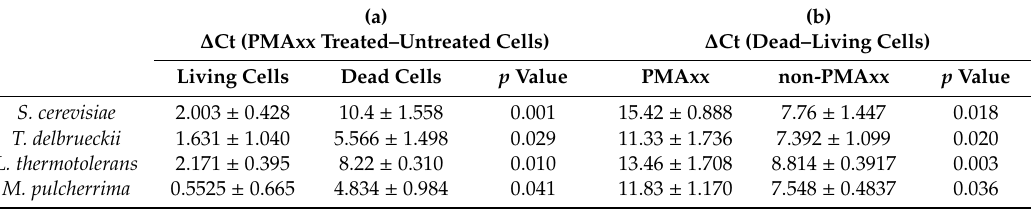
Figure 1. Schematic representation of the e ff ect of PMAxx treatment in living and dead cells. Red arrows represent the cycle threshold (Ct) reduction obtained by subtracting the mean Ct values of living cells from those of dead cells, (1) with or (2) without PMAxx treatment. Green arrows represent the Ct reduction obtained by subtracting the mean Ct values obtained from PMAxx-qPCR of (3) living or (4) dead cells from the mean Ct values obtained from non-dyed qPCR. Table 1. E ff ect of PMAxx treatment in 10 6 living or dead cells / mL of Saccharomyces cerevisiae (Sc), Torulaspora delbrueckii (Td), Lachancea thermotolerans (Lt) and Metschnikowia pulcherrima (Mp). (a) Ct reduction was obtained by subtracting the mean Ct values obtained from PMAxx treatment of living or dead cells from the mean Ct values obtained from untreated cells. (b) Ct reduction was obtained by subtracting the mean Ct values of dead cells from those of living cells, with or without PMAxx treatment. The results are expressed as the mean ± SD. The significance level for the unpaired t -test was p <